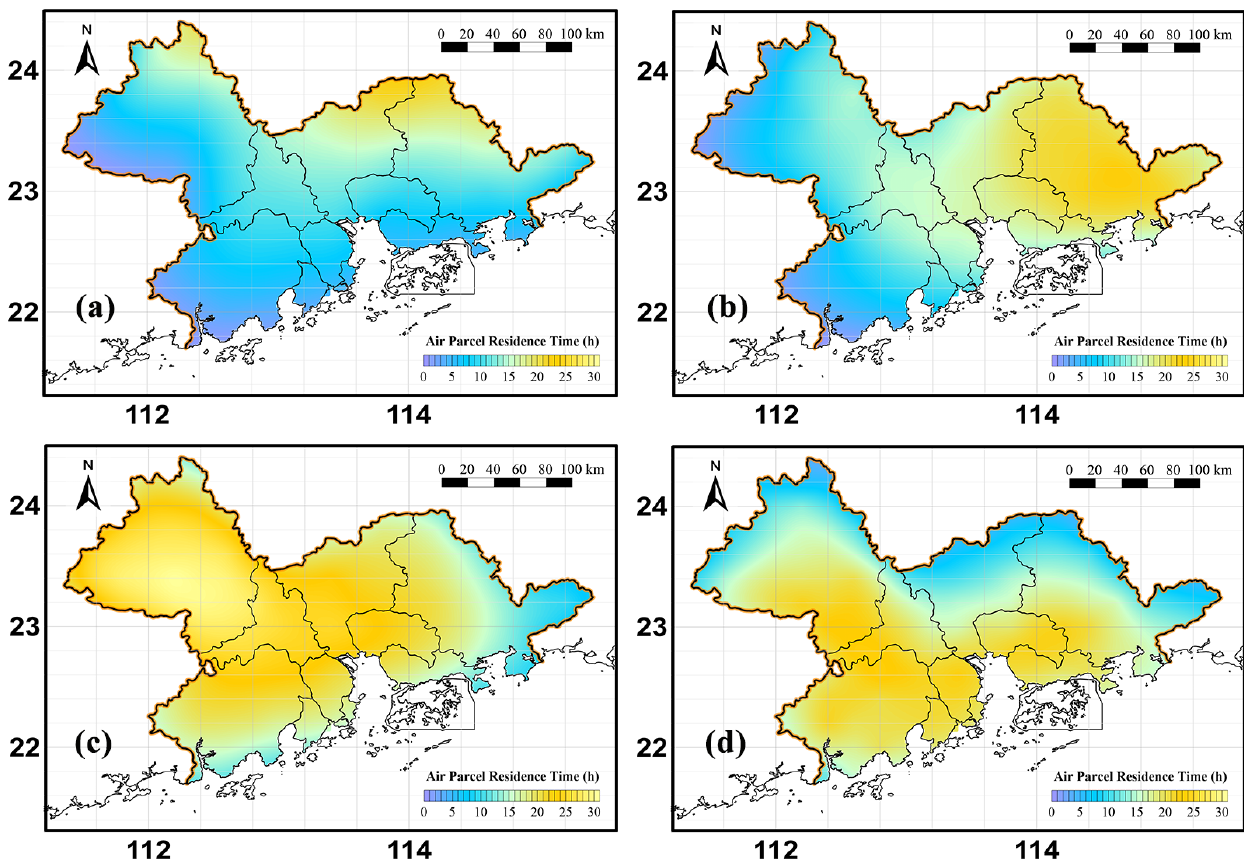
Figure 7. The spatial distributions of APRTs in the PRD for each scenario, i.e. (a) autumn (typhoon-induced), (b) autumn (no-typhoon), (c) summer (typhoon-induced) and (d) summer